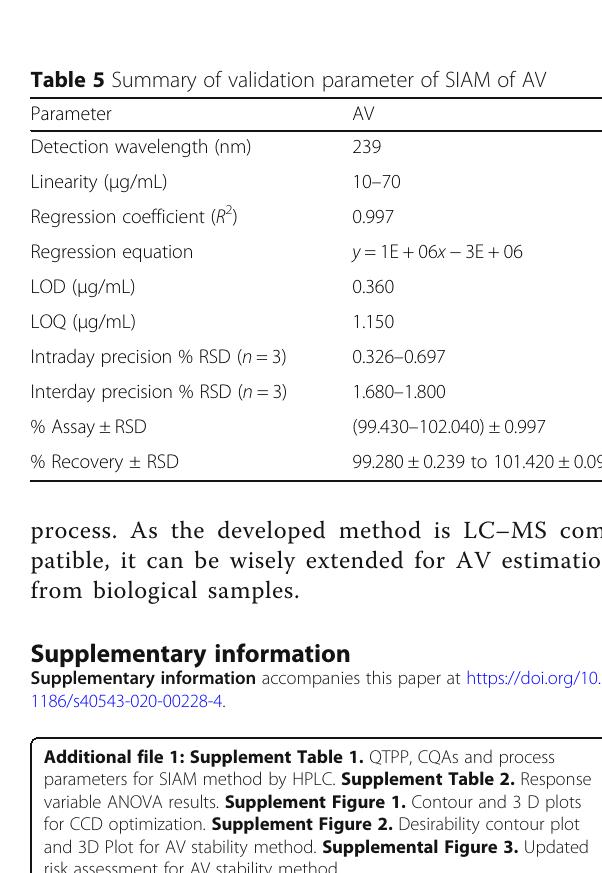
variable ANOVA results. Supplement Figure 1. Contour and 3 D plots for CCD optimization. Supplement Figure 2. Desirability contour plot and 3D Plot for AV stability method. Supplemental Figure 3. Updated risk assessment for AV stability method.